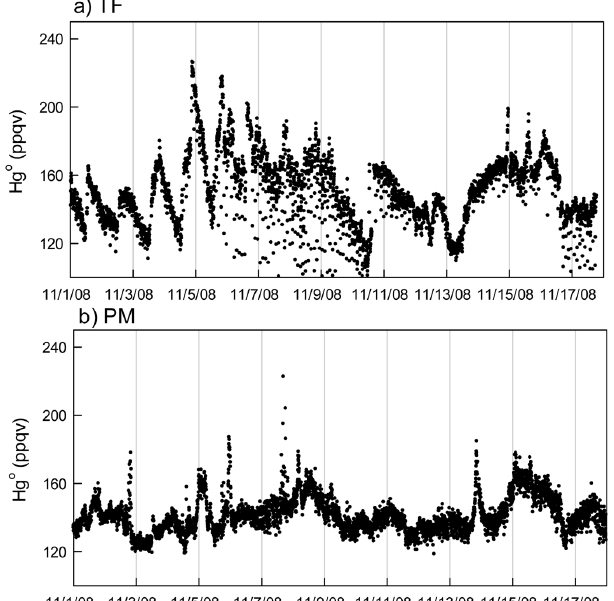
Fig. 3. Hg 0 mixing ratios at TF (coastal) (a) and PM (inland) (b) during the time period of 1–17 November